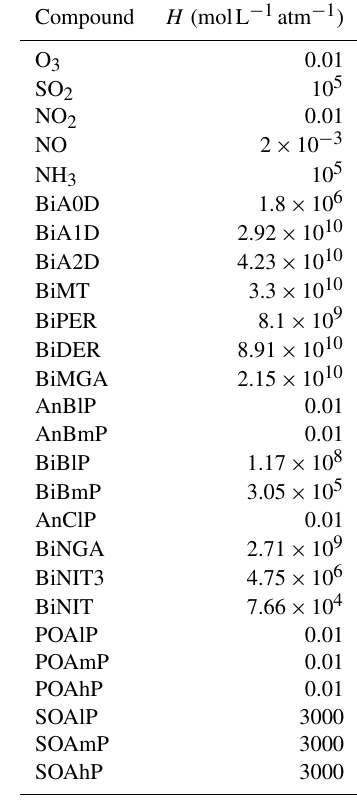
Table 4. Effective Henry’s law constants used for dry and wet depo- sition. High numerical values were used for HNO 3 and for gaseous H 2 SO 4 to take into account their hydrophilic